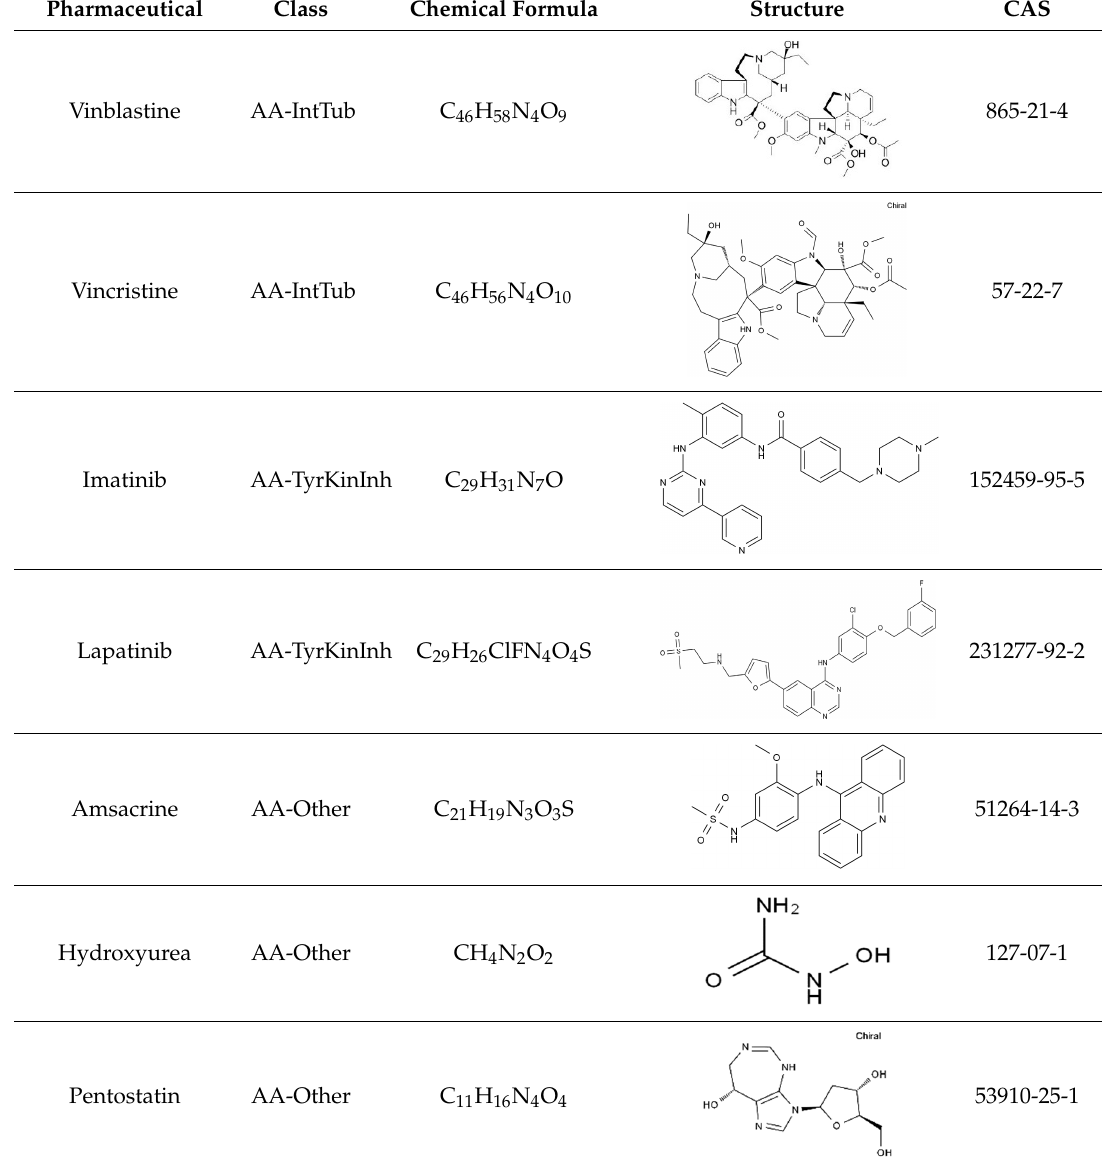
Top-1Inh—Topoisomerase-1 inhibitor; Top-2Inh—Topoisomerase-2 inhibitor; DNAIntAg—DNA-intercalating agents; IntTub—Interfere with tubulin; TyrKinInh—Tyrosine-kinase inhibitors. Anthracyclines (e.g., doxorubicin, daunorubicin, epirubicin, and idarubicin) are widely